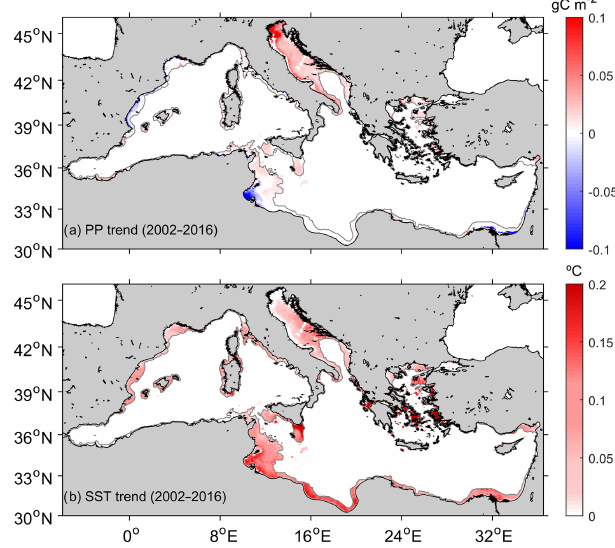
Figure 5. Trends in primary production and sea surface tempera- ture. Values correspond to the change per decade. (a) Theil–Sen trend in pelagic primary production (PP trend) estimated from daily values for the 2002–2016 period. (b) Trend in sea surface tempera- ture (SST trend). Only significant trends ( p < 0 . 05) are shown.